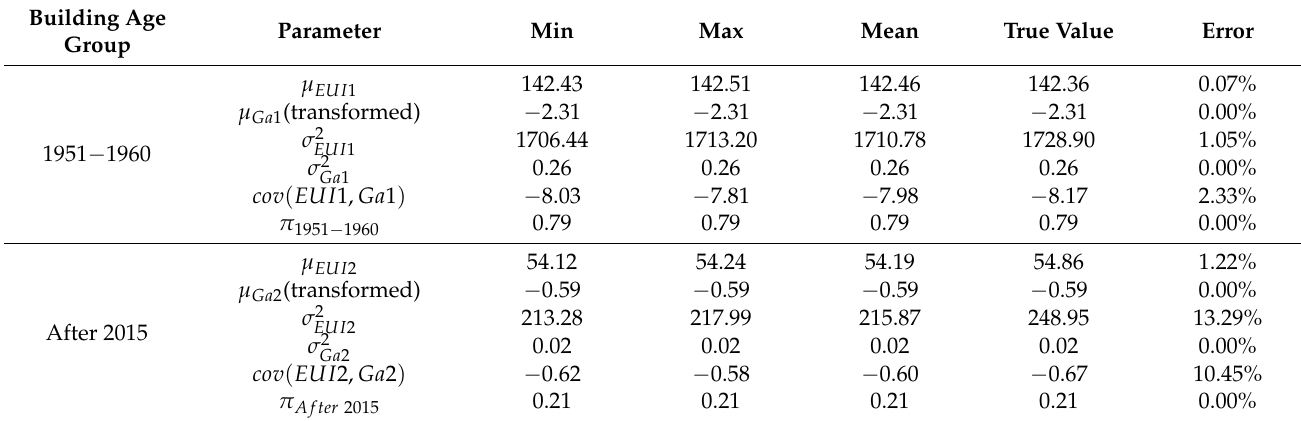
Table 4. Summary of the parameter estimation in the bivariate case.